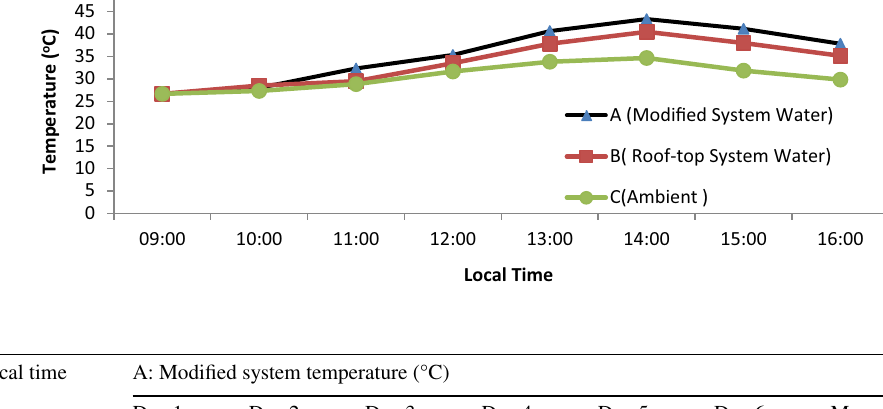
Table 1 Variation in daily hourly water temperature of PET bottles of improved SODIS during the experiment